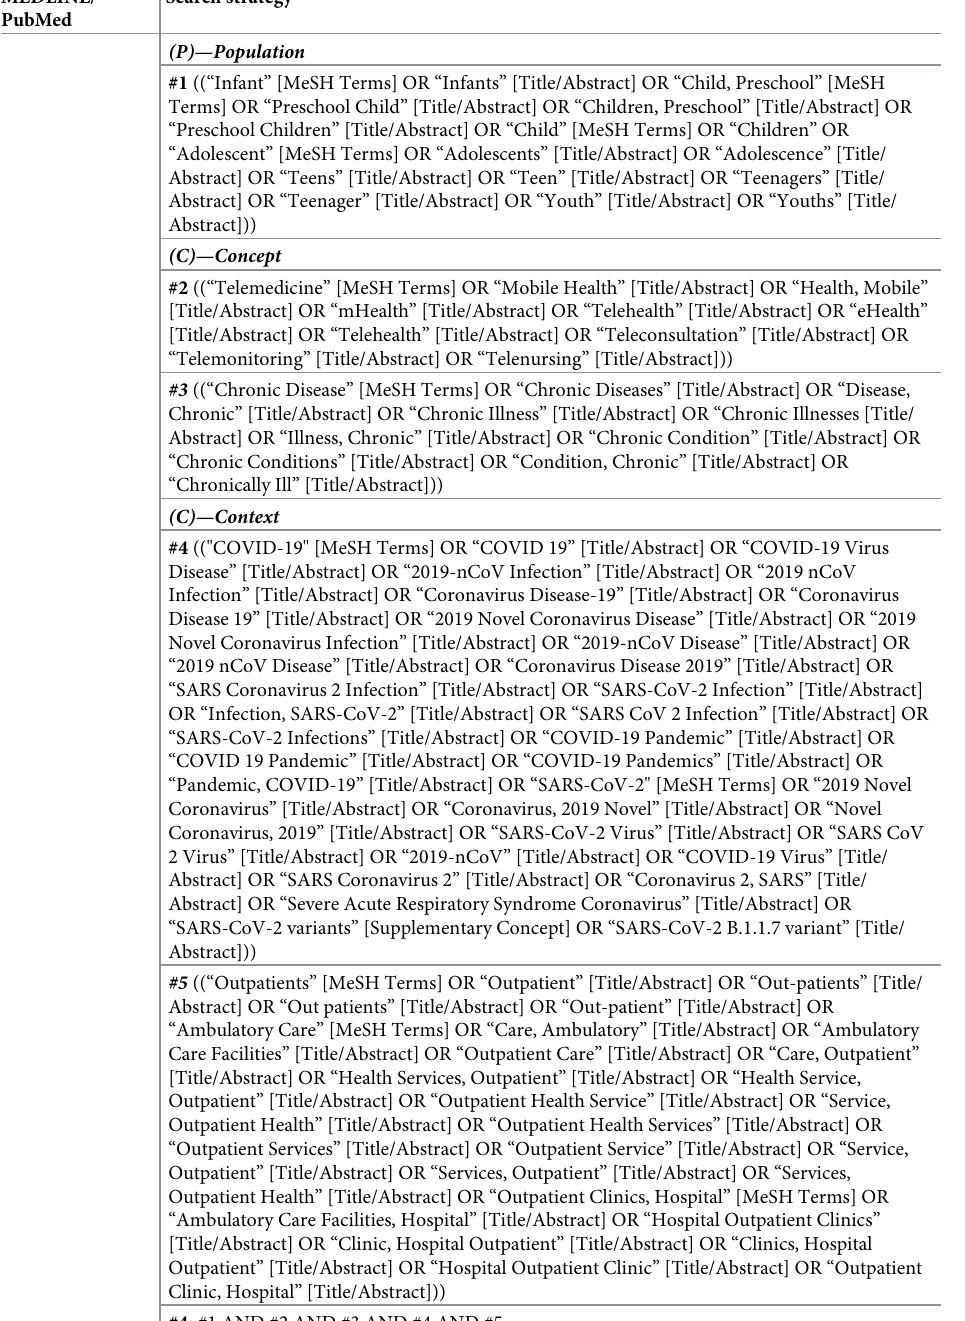
Table 1. Preliminary pilot search strategy in